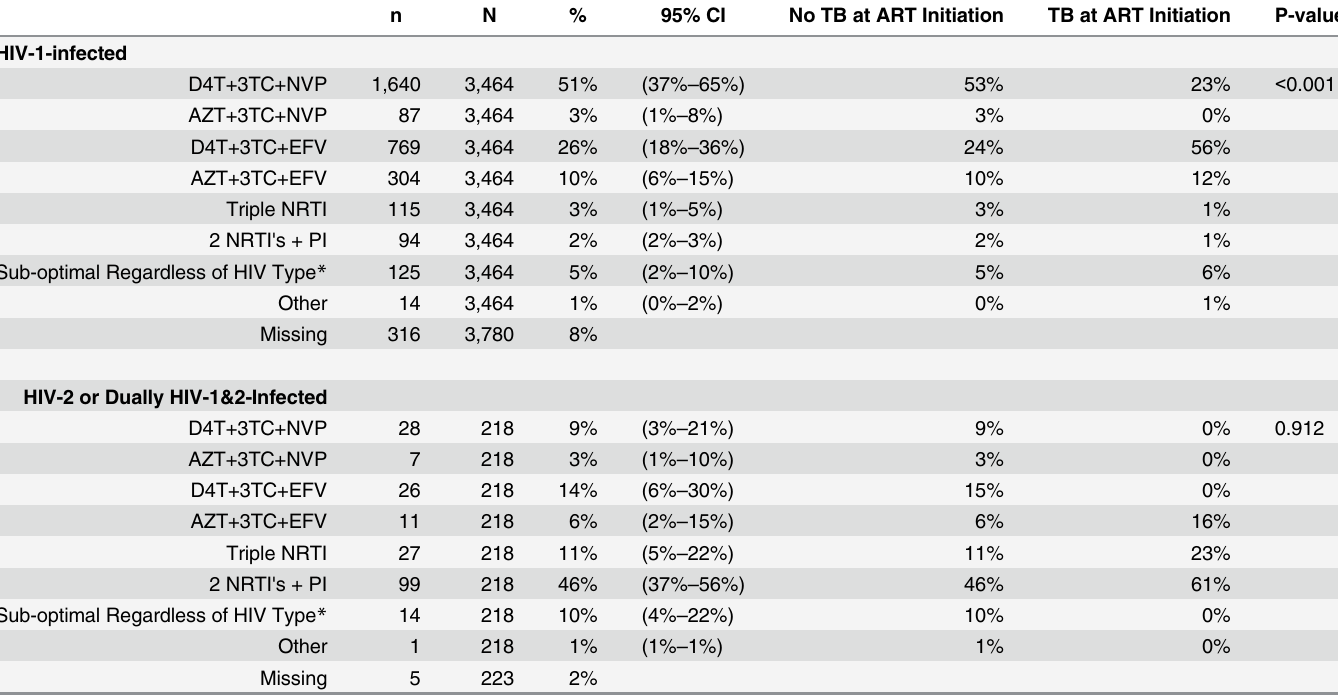
Table 2. First Line Antiretroviral Therapy Regimen Distribution by Tuberculosis Treatment Status and HIV Type at Antiretroviral Therapy Initiation in Côte d ’ Ivoire during 2004 –